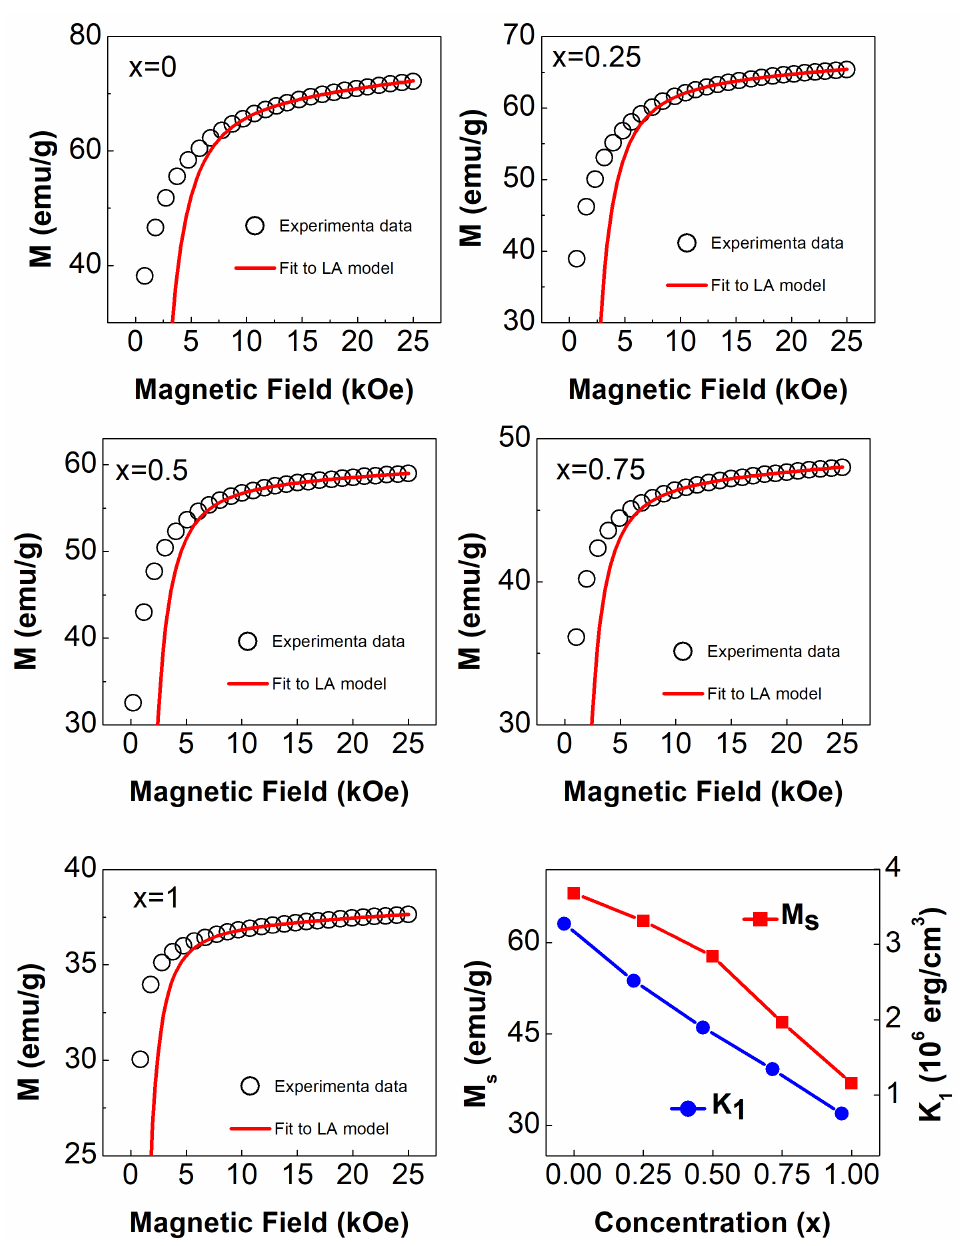
Figure 7. Room temperature magnetization curves of the Ni x Co 1 − x Fe 2 O 4 ferrites with 0 ≤ x ≤ 1, fit to LA model. The figure in the lower right corner shows the variation of M s and K 1 with Ni